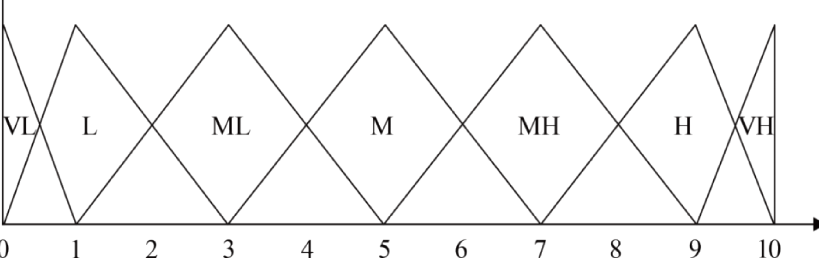
Figure 4. Membership function of a triangular fuzzy number.